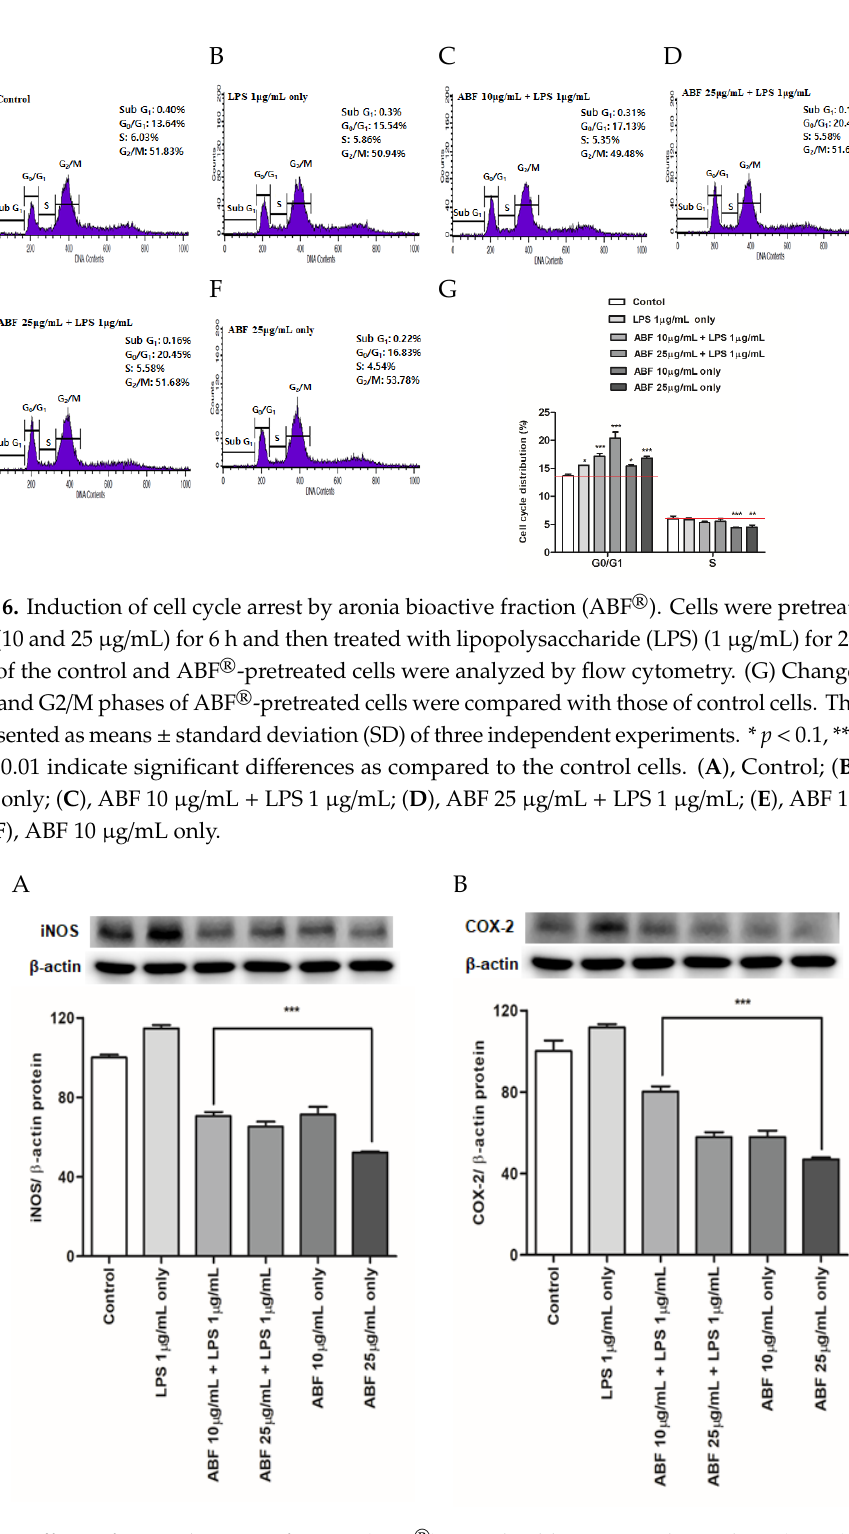
Figure 7. Effects of aronia bioactive fraction (ABF ® ) on inducible nitric oxide synthase (iNOS) ( A ) and cyclooxygenase-2 (COX-2) ( B ) protein expression in lipopolysaccharide (LPS)-stimulated BEAS-2B cells. ABF ® inhibited iNOS and COX-2 production (Figure 6). iNOS and COX-2 protein levels were confirmed by western blot. Expression of iNOS and COX-2 was markedly increased by LPS treatment and significantly reduced following ABF ® (10 and 25 μg/mL) pretreatment. Values are expressed as means ± standard deviation (SD) of triplicate experiments. *** p < 0.01 indicate significant differences as compared to the LPS-stimulated cells.